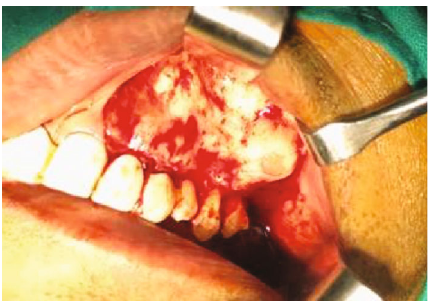
Figure 1: Intraoperative image of case 1 presenting with a mild swelling in the left premolar molar region. The anterior teeth have been root canal treated and